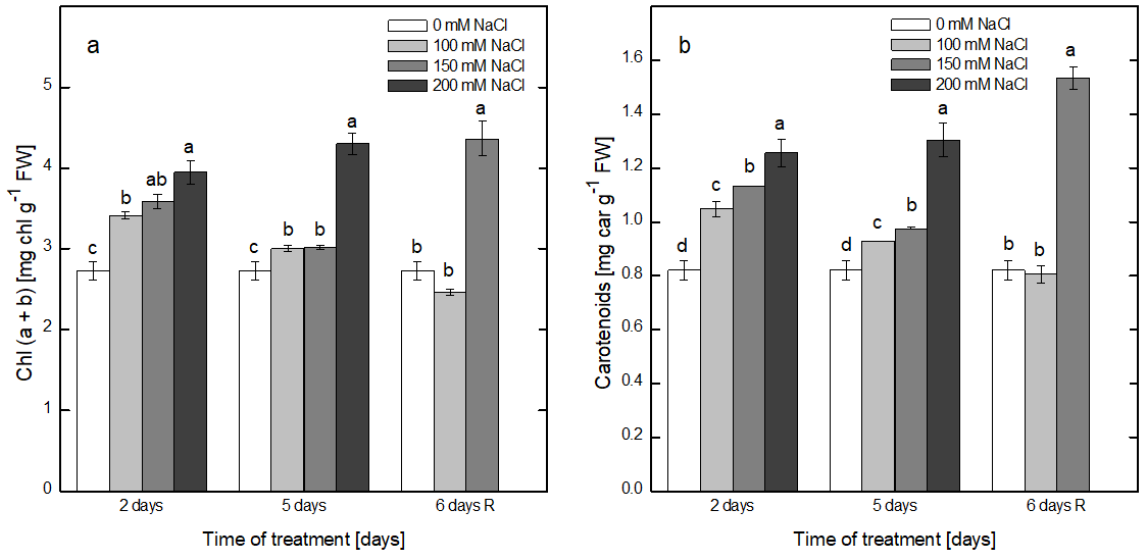
Figure 3. Effect of treatment with increased concentrations of NaCl (0, 100, 150 and 200 mM) on the leaf pigment content of the pea plants treated with the respective concentration for 2 and 5 days and after recovery on pure Hoagland’s solution (6 days R). Results are presented as means ± SE. Three independent experiments were performed, and four parallel samples were evaluated at each time point ( n = 12): ( a )–chlorophyl a + b (Chl a + b), ( b )–total content of carotenoids (Carotenoids). Different letters indicate significant differences between values for the control plants (0 mM NaCl) and plants treated with increasing concentrations of NaCl at p < 0.05 for the respective period of the experimental setup (2 and 5 days of treatment and the recovery period).